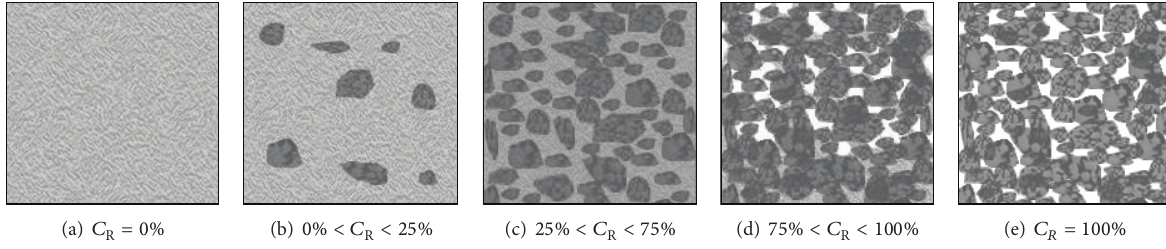
Figure 1: Different rock contents of soil-rock mixture medium macrostructure